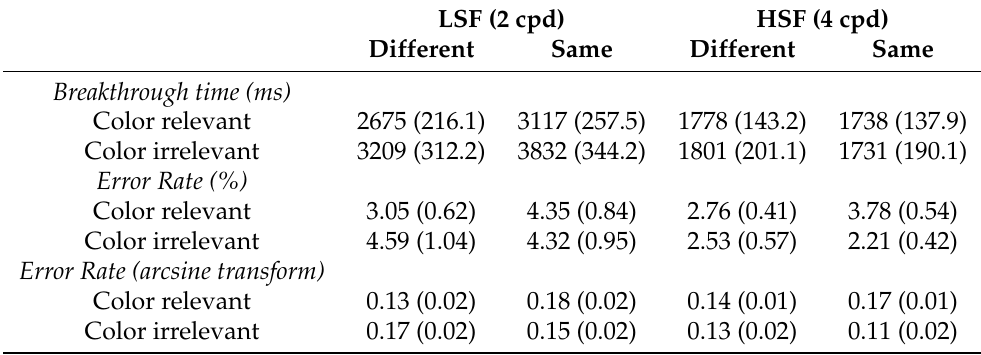
Table 1. Means and standard errors (in parentheses) for breakthrough time and error rate in the eight experimental conditions of the present